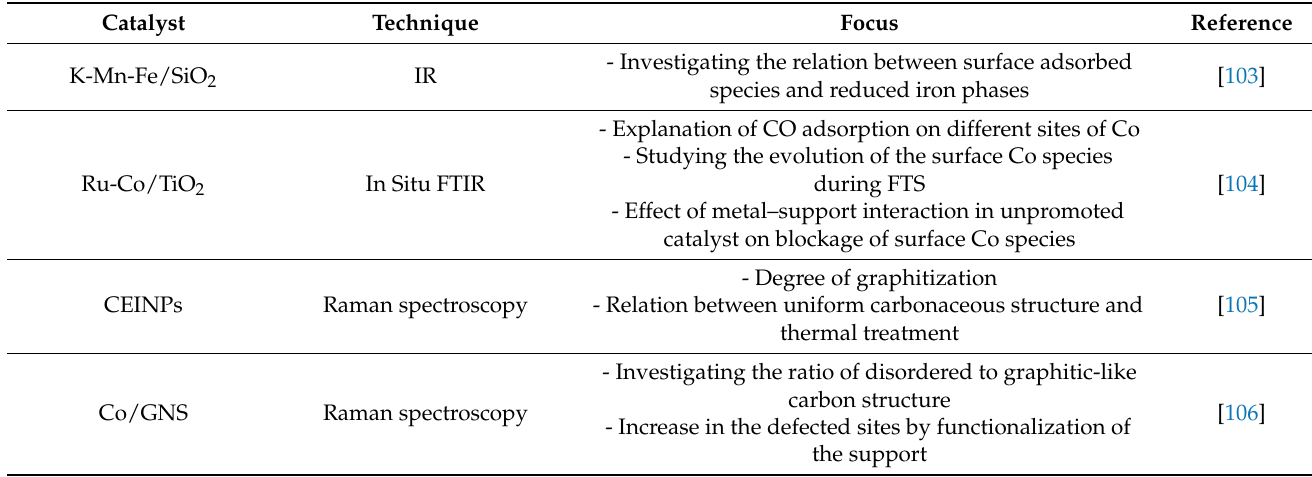
Table 6. Spectroscopy-based analysis for Fe and Co catalyst in